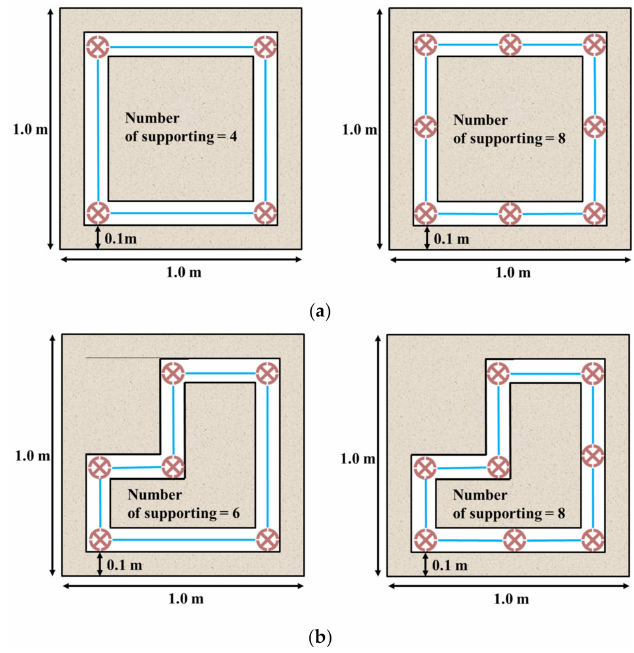
Figure 11. Cases of experiments for RSIM: ( a ) square and ( b ) multisection